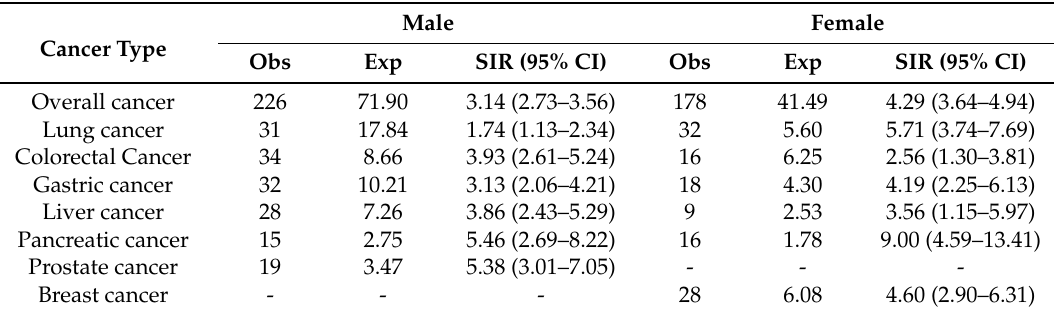
Table 4. Standardized cancer incidence ratios in patients with type 2 diabetes.